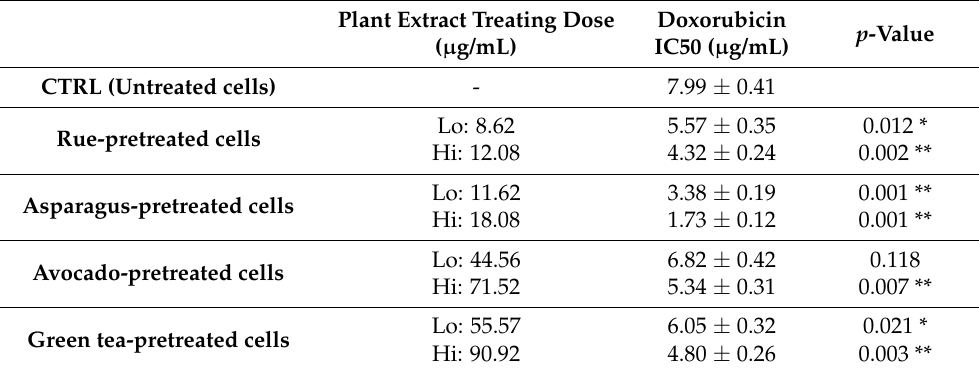
Table 1. IC50 of plant extracts on HepG2 cells after treatment for 48 h.